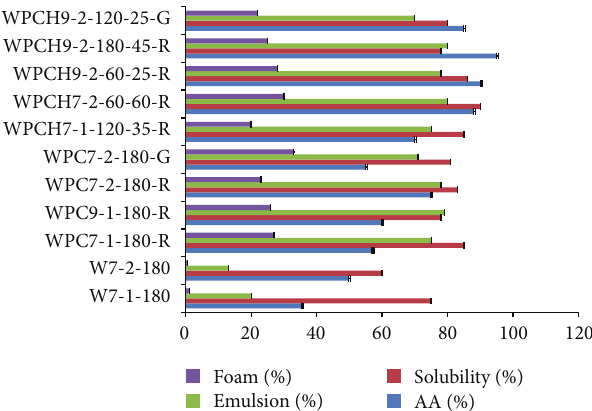
Figure 4: Functional properties of glycosylated products from whey milk in individual experiments with ribose and glucose at 50 ∘ C and variations of pH 7 and pH